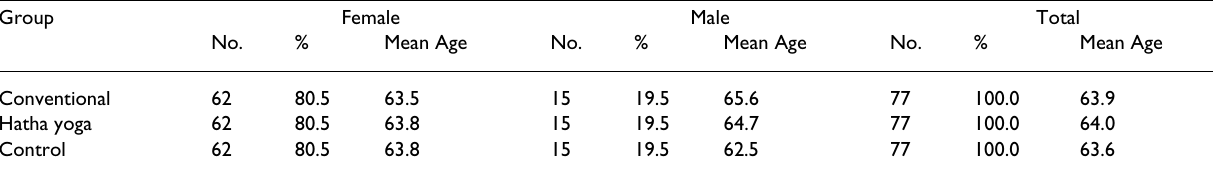
Table 1: Frequency of treated type 2 diabetic subjects according to group, sex and age Group Female Male Total No. % Mean Age